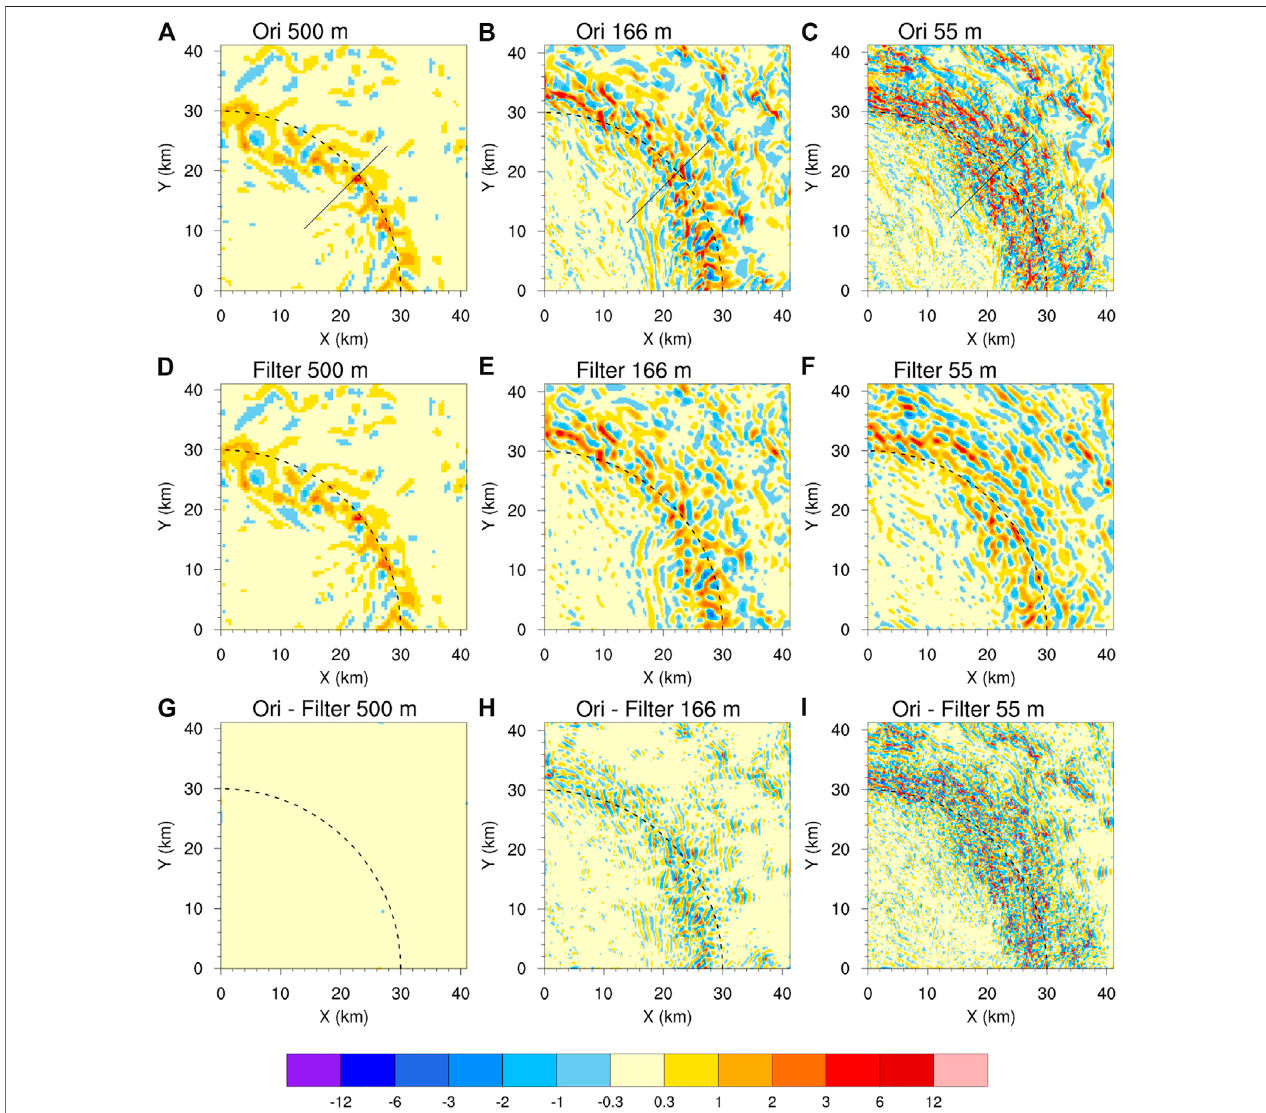
FIGURE 6 | Horizonal distributions of vertical velocity (m s − 1 ) at the 183-m height in the northeast quadrant at t (cid:2) 8.75 h of the simulation from the grid spacings of (A) 500 m, (B) 166 m,and (C) 55 m. (D) – (F) and (G) – (I) arethesameas (A) – (C) butforscaleswiththewavelengthslargerthan1,600 mandthosewithwavelengthsless than 1,600 m,